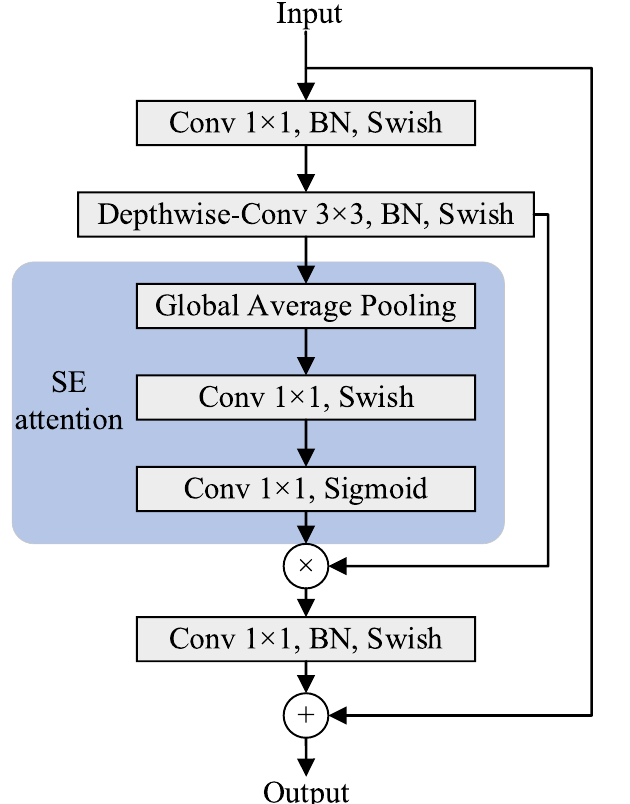
Figure 4. Convolution structure diagram of EfficientNet.